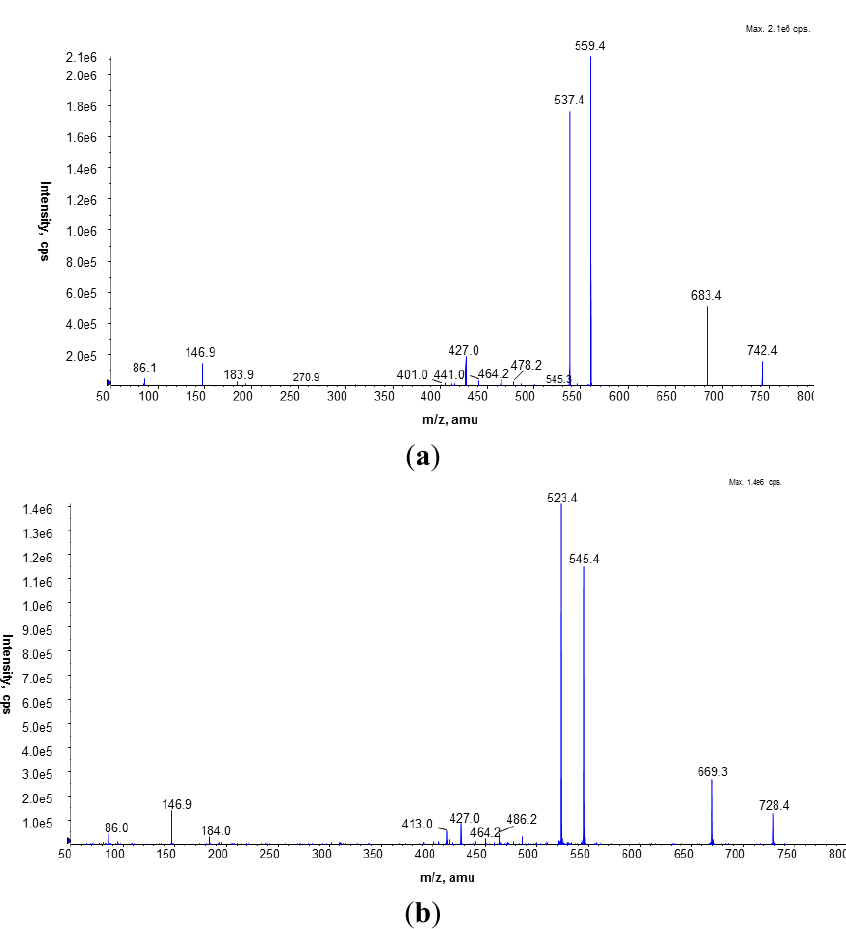
Figure 5. ( a ) CID spectrum of unlabeled 16:0/15:0 PC molecular species identified in the lipid mixture isolated from the inner membrane ( L. dumoffii cultivated on the medium without labeled choline), recorded under NP LC/MS conditions